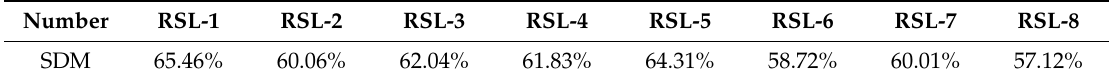
Table 7. Sti ff ness degradation